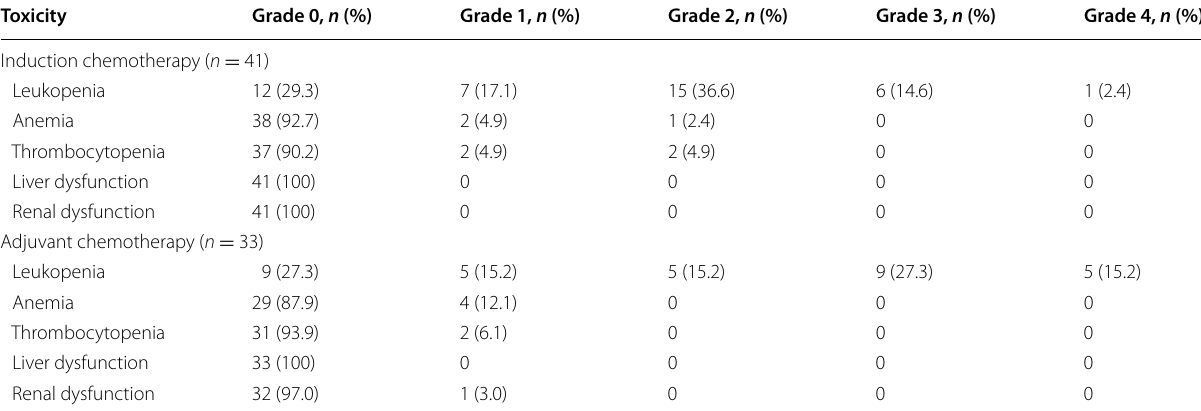
Table 4 Frequencies of chemotherapy-related acute toxicities among the patients